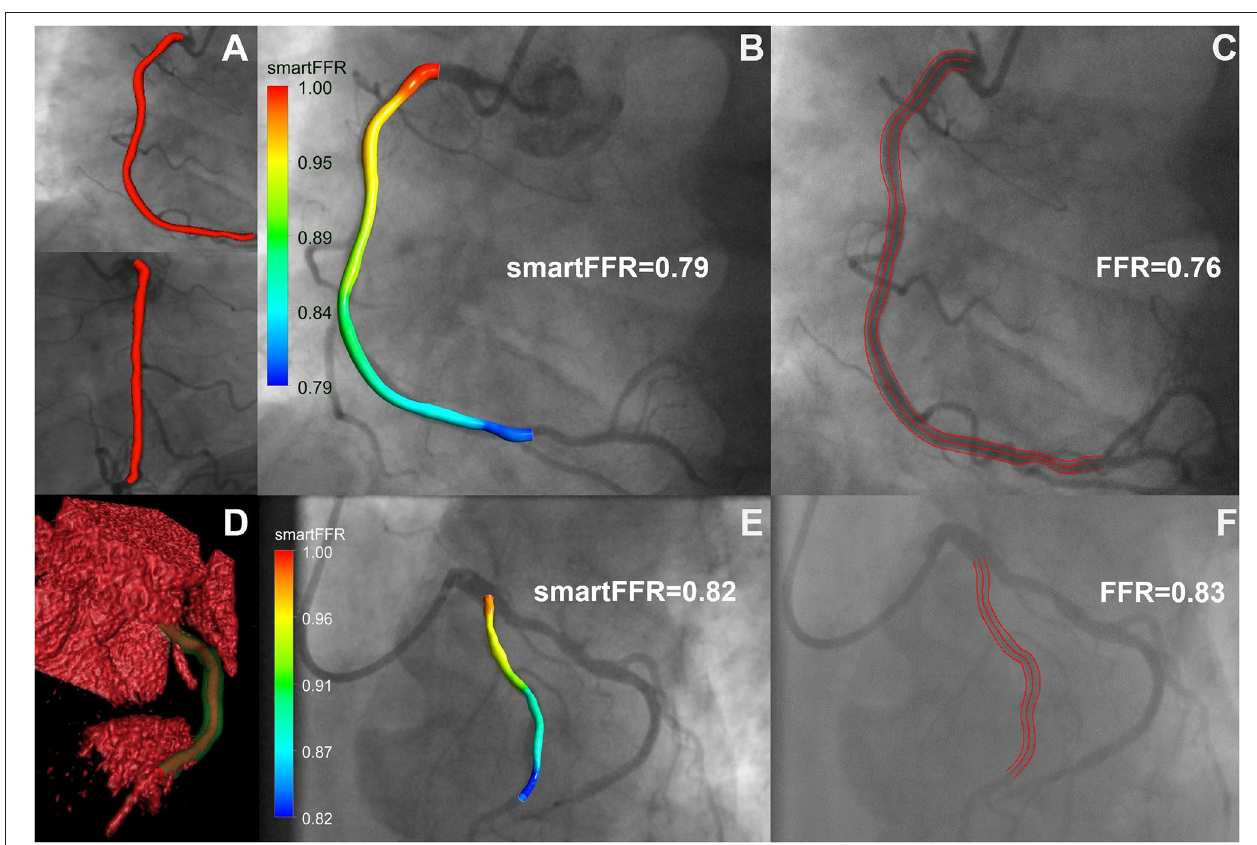
FIGURE 8 | Top row: ICA-derived model, Bottom row: CCTA-derived model. (A) 3D reconstructed ICA-derived model back-projected on the two utilized angiographic views using our in-house developed software platform. (B) ICA-derived 3D model with smartFFR value, back-projected on the respective angiographic image, (C) ICA image with respective invasively measured FFR value and delineation of the segment of interest, (D) Volume rendered 3D reconstructed model with our in-house developed software platform. The outer wall is depicted in transparent green and the lumen in orange. (E) CCTA-derived 3D model with smartFFR value, back-projected on the respective angiographic image (F) ICA image of the CCTA model with respective invasively measured FFR value and delineation of the segment of interest.